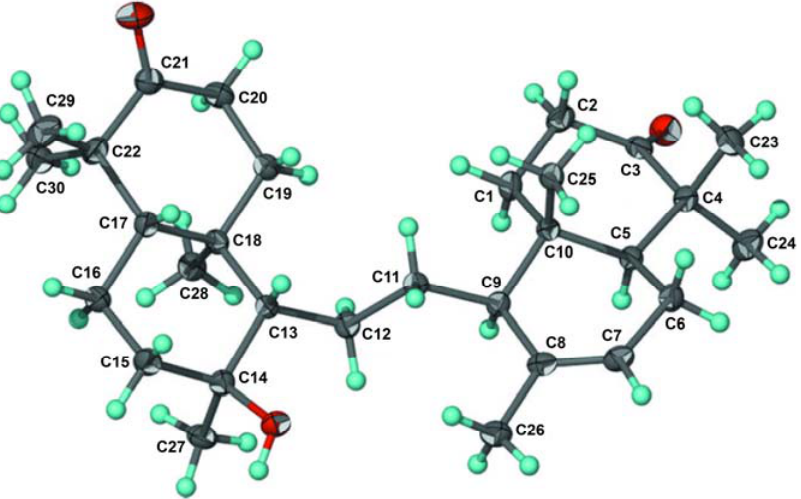
Figure 5. ORTEP drawing for kokosanolide B reproduced from Supratman et al.